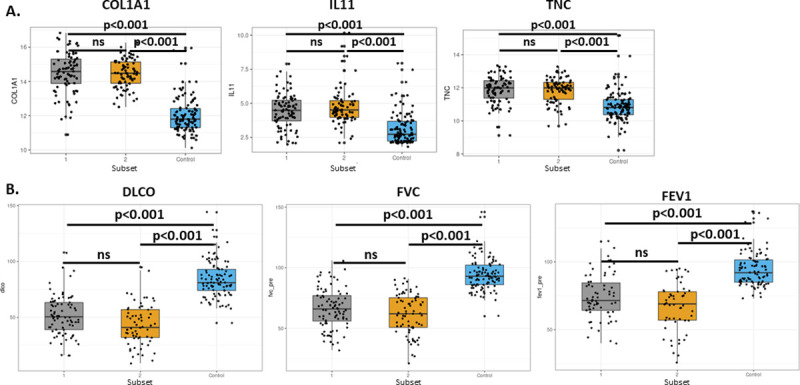
Evaluation of fibrotic markers and clinical parameters in IPF subsets.A. Expression of fibrosis markers in IPF subsets based on the analysis in Fig 1 in GSE47460 (Kaminski-LGRC bulk expression cohort) [14–17] as compared to healthy controls (‘Control’). Adjusted p values determined by ANOVA and post-hoc Dunn’s test are reported on plots. B. Distribution of clinical parameters in IPF subsets based on the analysis in Fig 1 as reported in GSE47460 (Kaminski-LGRC bulk expression cohort) [14–17] as compared to healthy controls (‘Control’). %DLCO, FVC and FEV1 values represent pre-lung transplant values reported in GSE47460 (Kaminski-LGRC bulk expression cohort) [14–17]. Adjusted p values determined by ANOVA and post-hoc Dunn’s test are reported on plots.